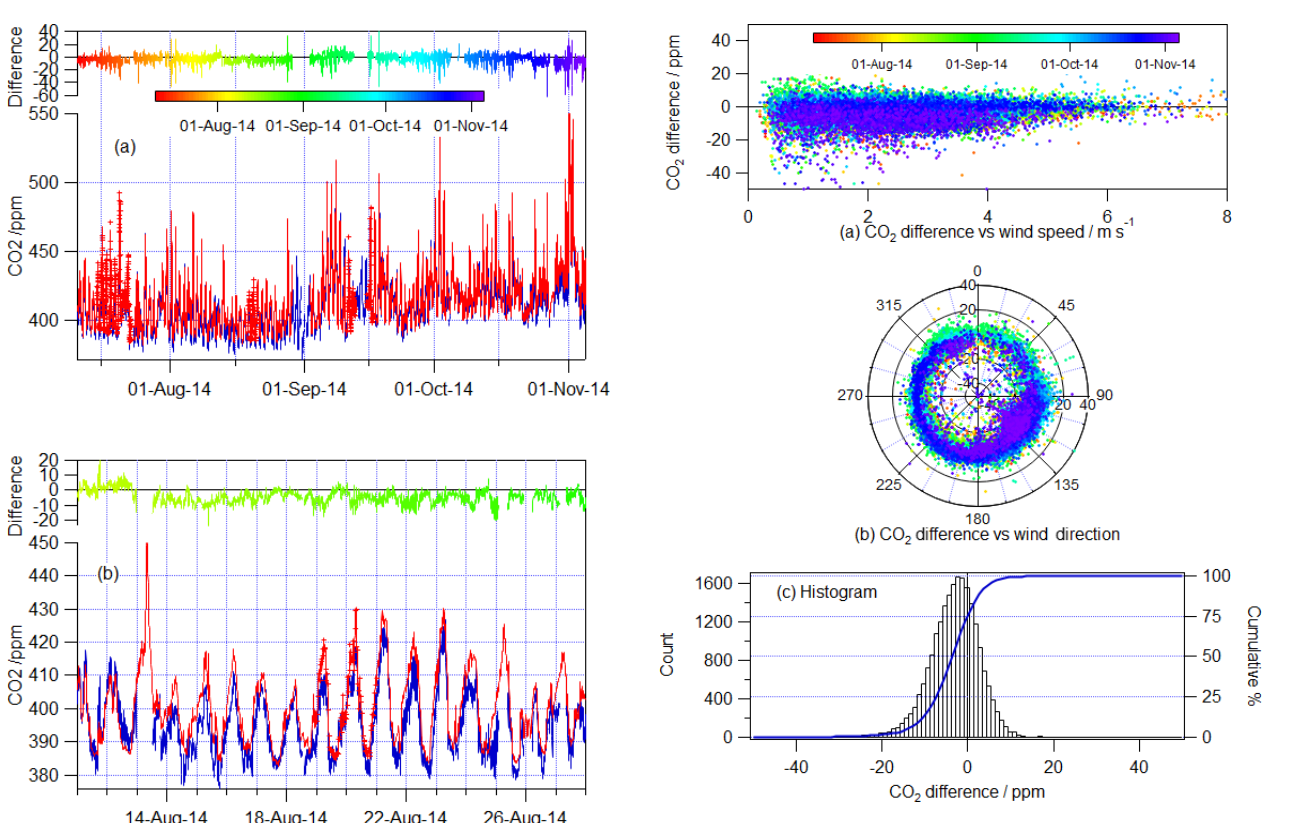
Figure 10. CO 2 mole fraction differences between open-path and in situ measurements (OP – in situ) (a) vs. wind speed, (b) as a wind speed rose and (c) as a histogram of the differences. The standard deviation of the distribution is 6.3ppm. (a, b) are coloured by time to compare with Fig.